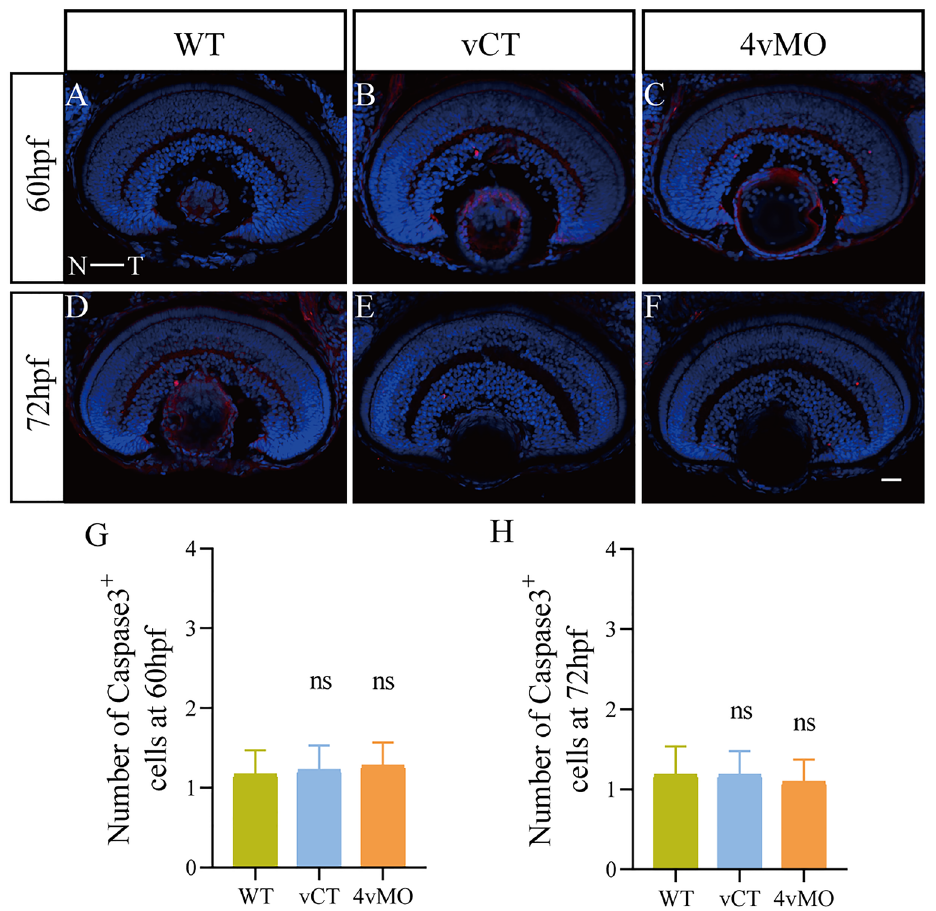
Figure 5. Effects of lhx4 knockdown via vivo - MO in the eyes on the apoptosis in the retina. All figures are horizontal sections along the temporal-nasal axis (T-N). ( A – F ) Immunofluorescence staining with Caspase3 at 60 hpf and 72 hpf. Blue, DAPI staining of the nuclei. Scale bar = 20 μm. ( G , H ) Statistical analysis of the number of Caspase3 + cells in WT, vCT, and 4vMO retinas at 60 hpf and 72 hpf. ns, P > 0.05; vCT vs. WT; 4vMO vs. vCT. Results are presented as the mean ± SEM (n ≥